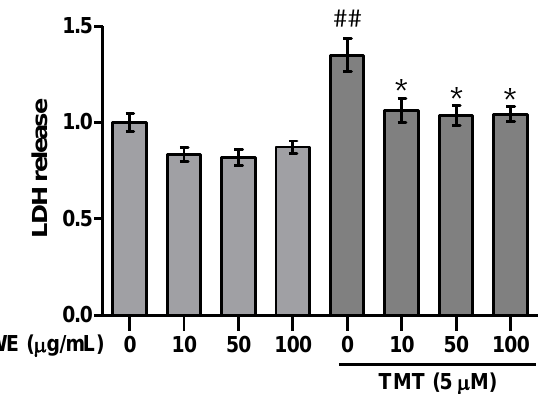
Figure 2. Protective effect of the Protaetia brevitarsis seulensis’ water extract (PBWE) on trimethyltin (TMT)-induced cytotoxicity. The PBWE treatment (10–100 µ g/mL) was confirmed to reduce the cytotoxic activity of 5 µ M TMT on hippocampal neurons in the lactate dehydrogenase (LDH) assay. Values are reported as mean ± SE. ## p < 0.01 vs. saline-treated group, * p < 0.05 vs. TMT-alone treated